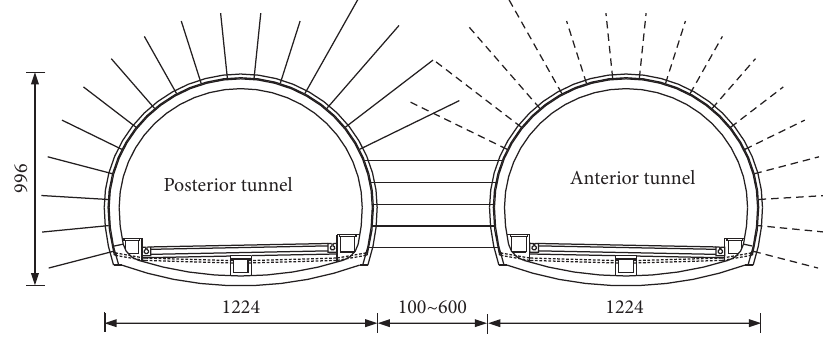
Figure 2: Profile view of 1–1 (unit: cm).